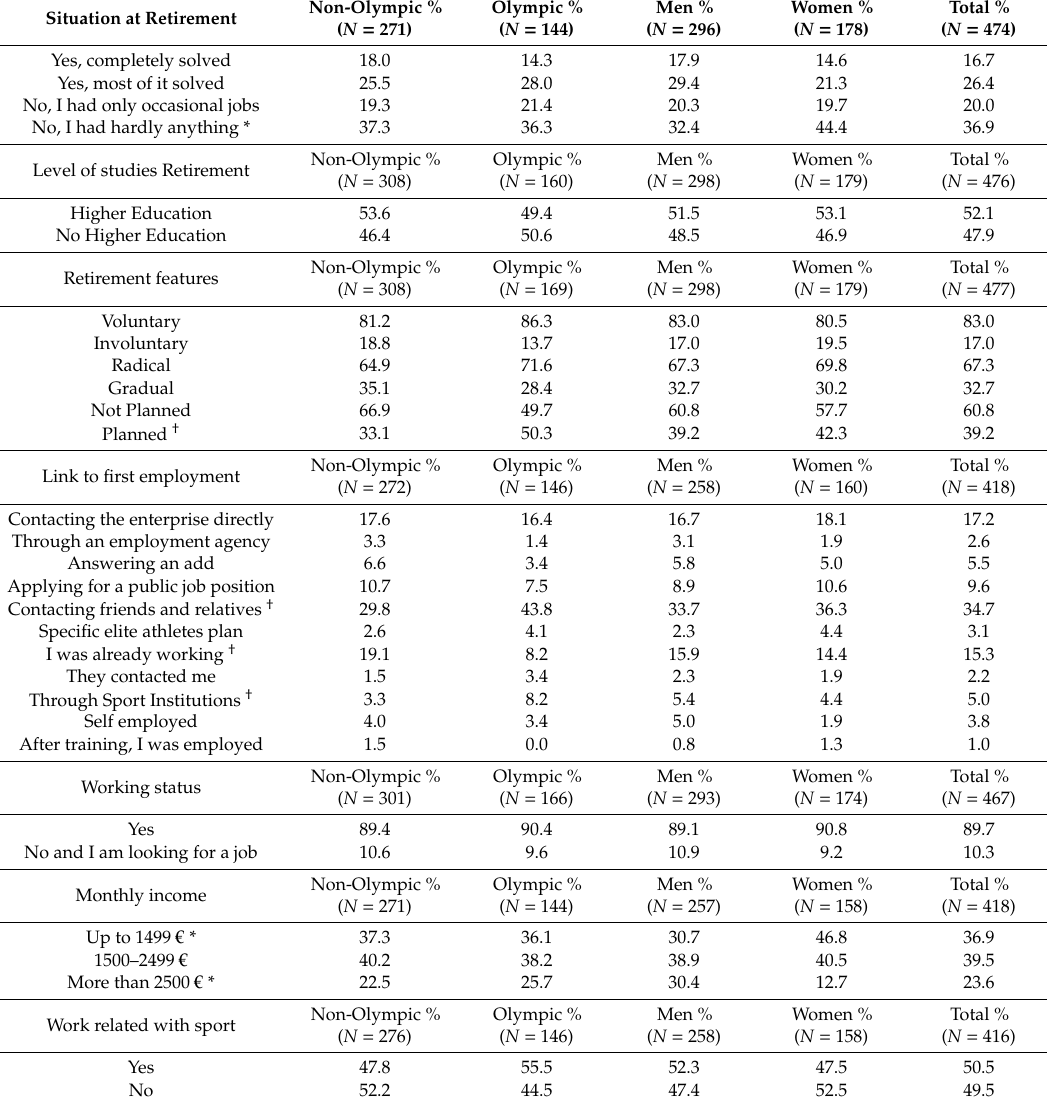
Table 2. Distribution of the employment process regarding on experienced the Olympic games and